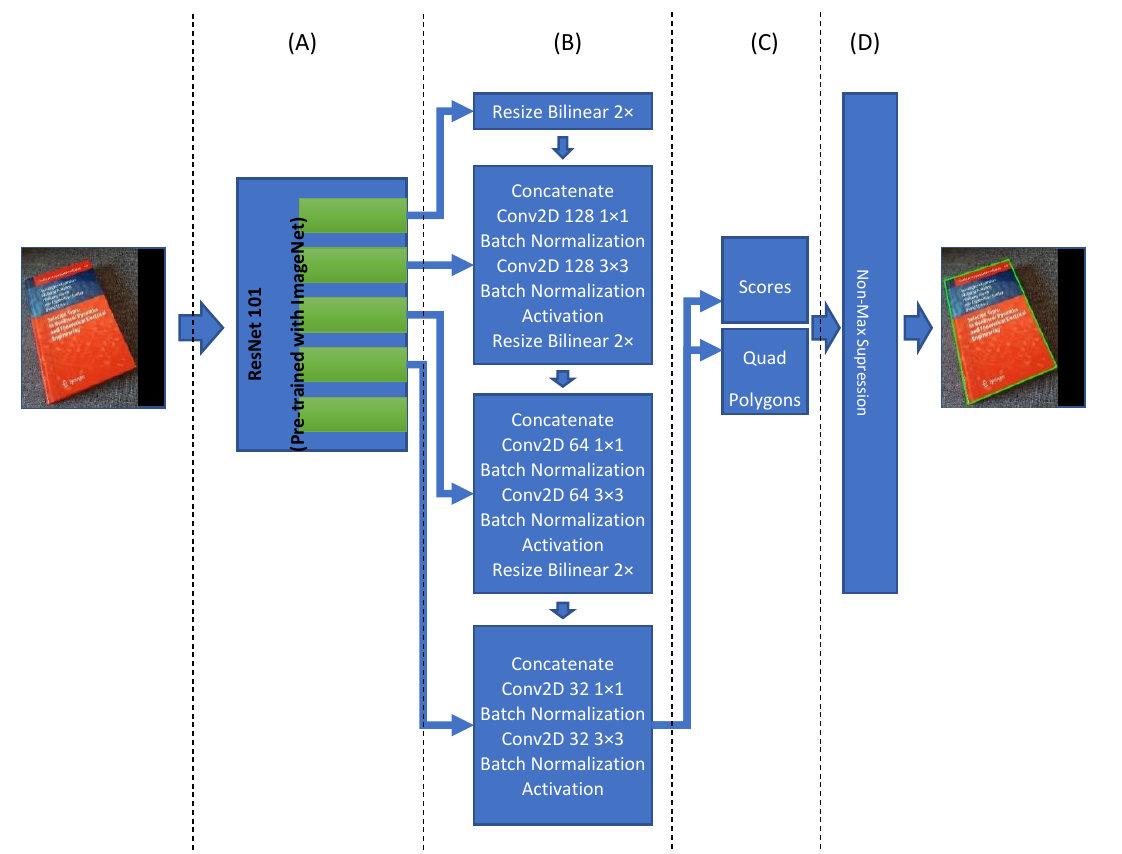
Figure 4. The document detection model contains three parts or sections: ( A ) Feature extraction based on ResNet101; ( B ) Further feature extraction layers; ( C ) Output layers; and ( D ) a Non-Max Suppression layer.